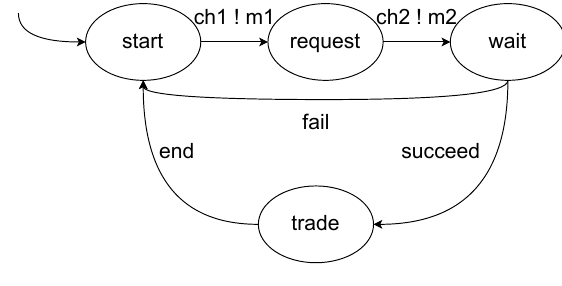
Figure 2. The client A model.